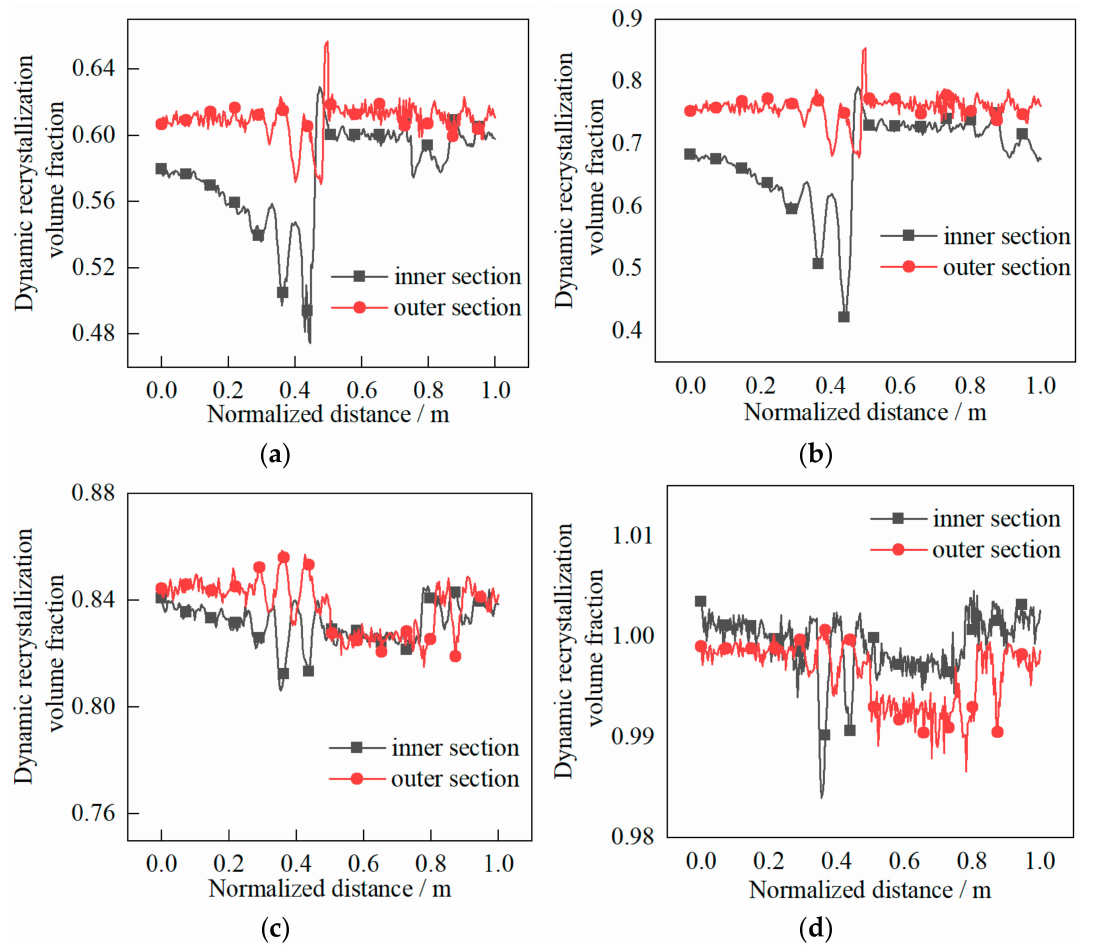
Figure 16. Evolution characteristics of recrystallization volume fraction in two passes of rolling: ( a ) first pass rolling, without shear effect; ( b ) first pass rolling, with shear effect; ( c ) second pass rolling, without shear effect; ( d ) second pass rolling, with shear